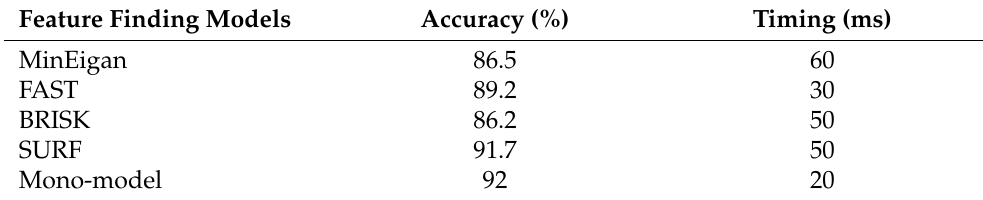
Table 5. Feature Identification Schemes.